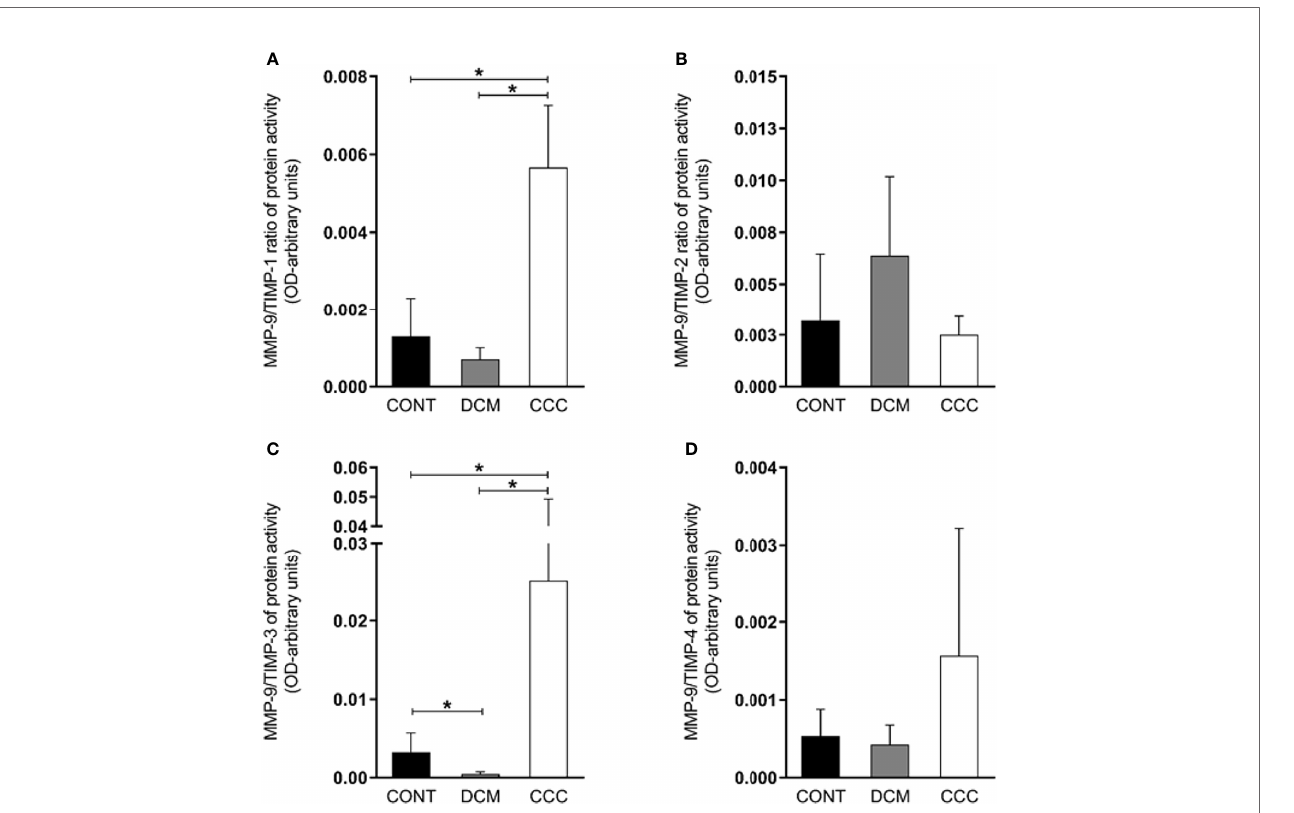
FIGURE 6 | Ratios of MMP9/TIMP in heart tissue from CCC and DCM samples. Activity of MMP-9/expression protein TIMP stoichiometric ratios were calculated for samples CCC, DCM and control (A) MMP-9/TIMP-1. (B) MMP-9/TIMP-2. (C) MMP-9/TIMP-3. (D) MMP-9/TIMP-4. Groups were compared by a non-parametrical test (Mann – Whitney Rank Sum Test) with GraphPad Prism software (version 6.0; GraphPad). Results were expressed as mean ± SD and arbitrary units. *P -values were considered signi fi cant if p-value (0.05) corrected for multiple comparisons by Bonferroni ’ s method (corrected p- value = 0.05/3 =